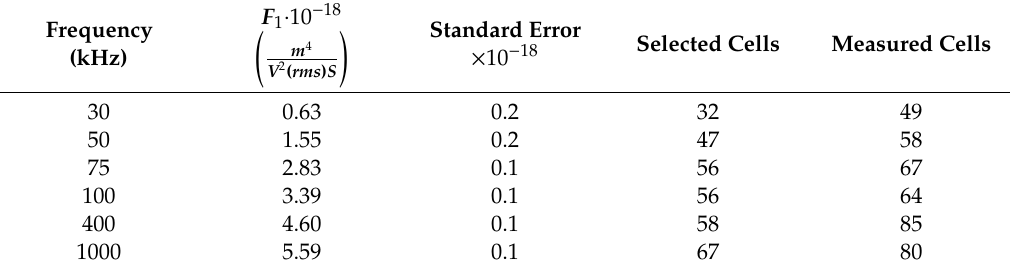
Table 4. Collected values for coupled cells.